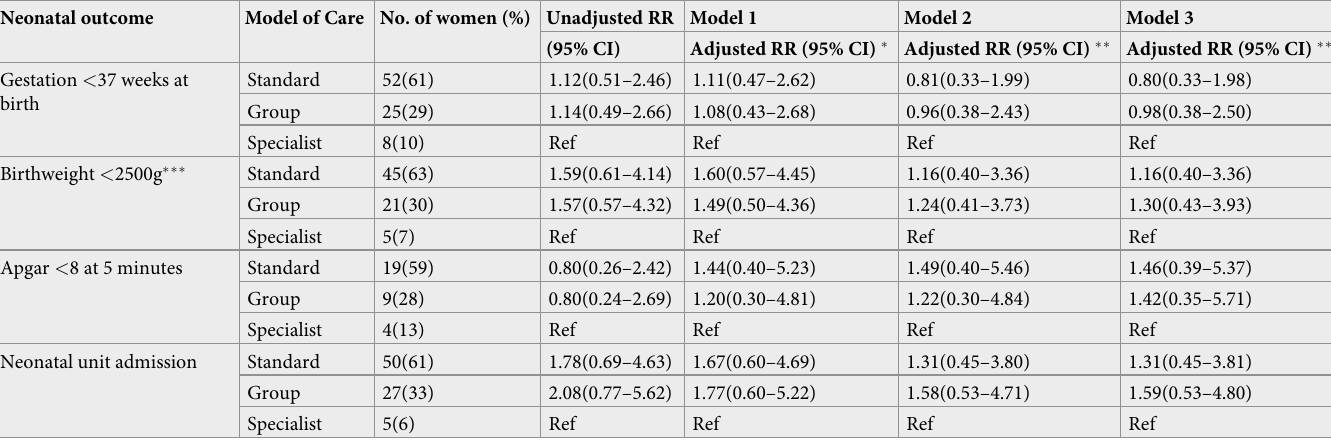
� Model 1: Adjusted for demographics ethnicity, age, parity, IMD score, any social and medical risk factors at booking and onset of labour. �� Model 2: Model 1 + Adjustment for place of antenatal care (community or hospital). ��� Model 3: Model 2 + Adjustment for service provider attended (A or B).